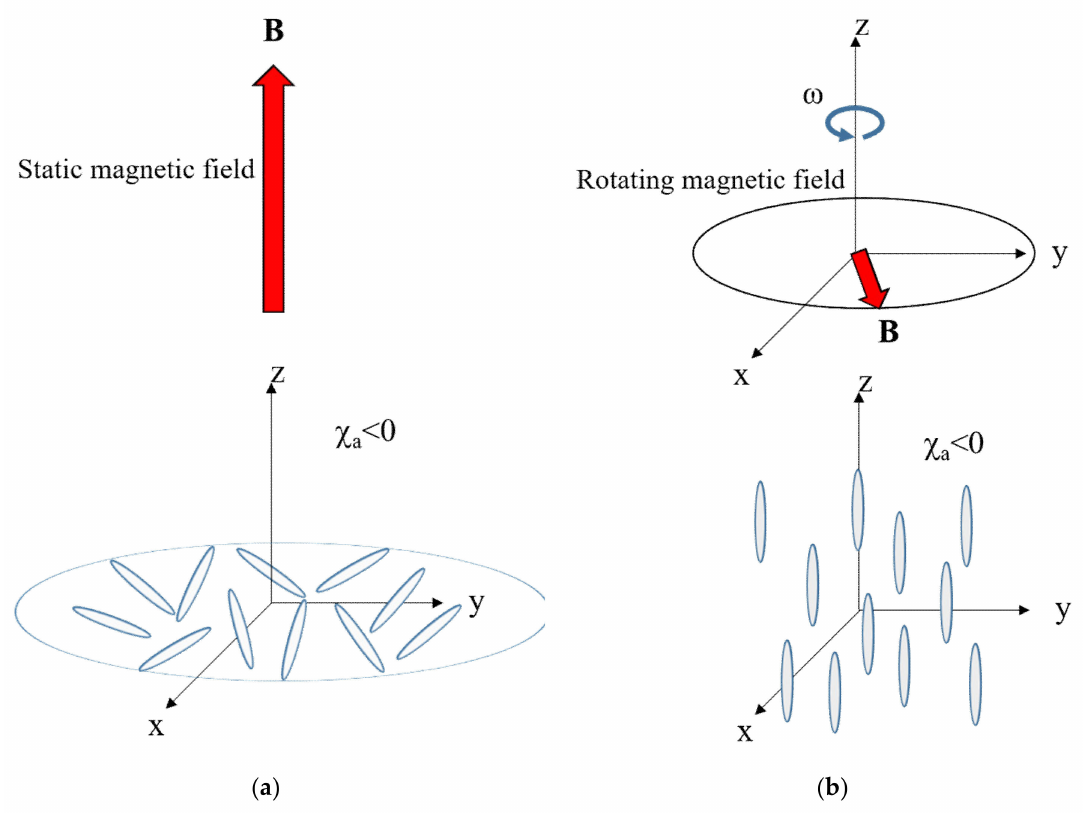
Figure 7. Schematic drawing of applying magnetic fields and expected alignments of the fiber with χ < 0. ( a ) Static magnetic field and ( b ) rotating magnetic a